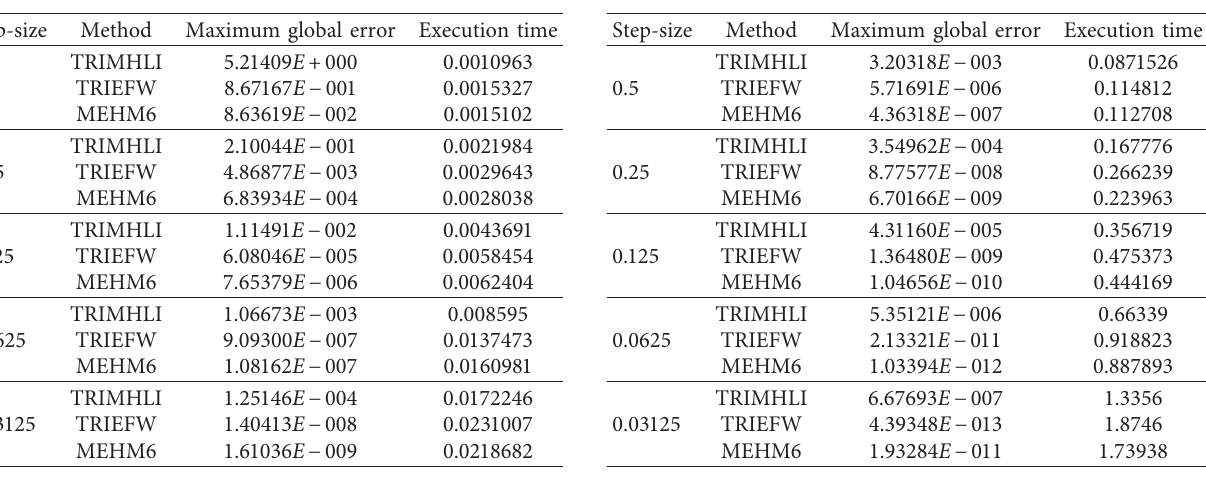
Table 5: Numerical results for Problem